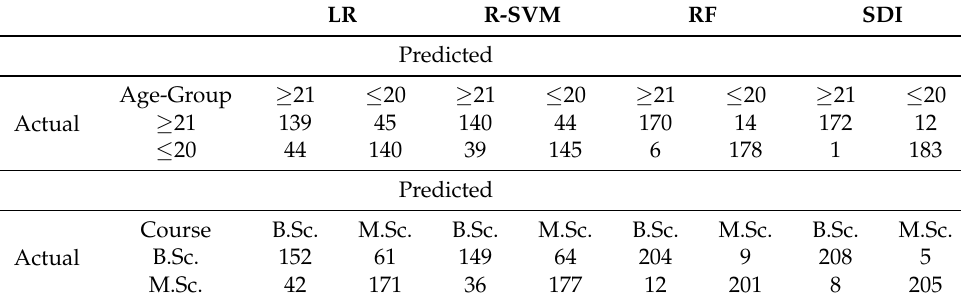
Table 4. Age-group and Course Identification Confusion matrix.